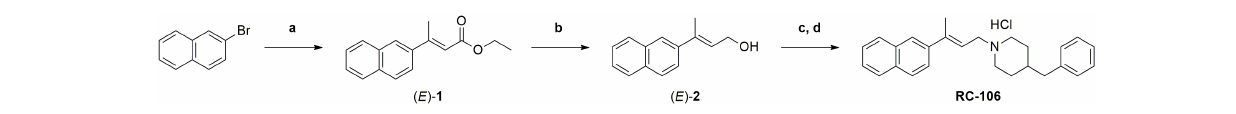
SCHEME 1 | Synthesis of RC-106 . Reagents and conditions: (a) ( E )-ethyl crotonate, Pd EnCat R (cid:13) 40, TEAC, NaOAc, DMF anhydrous, N 2 atm., 105 ◦ C; (b) LiAlH 4 (1M in THF), Et